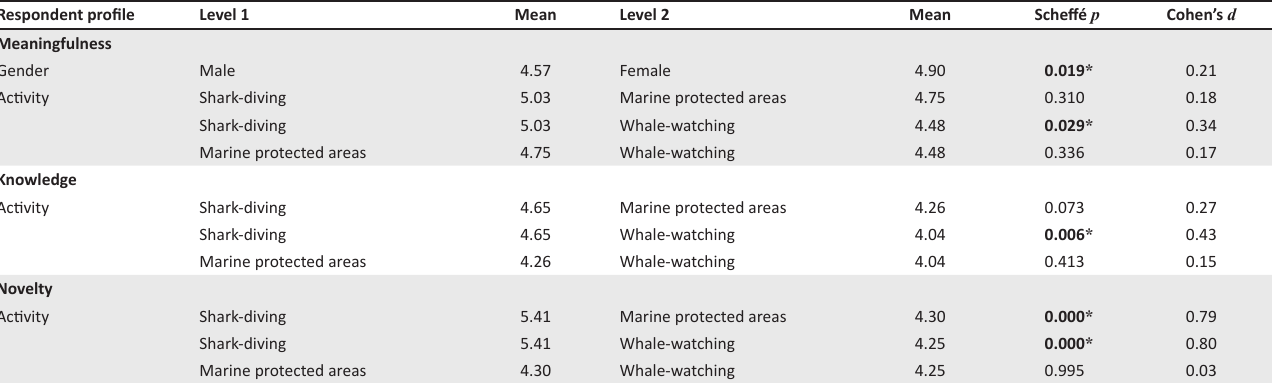
TABLE 8: Scheffé post-hoc analysis: all activities